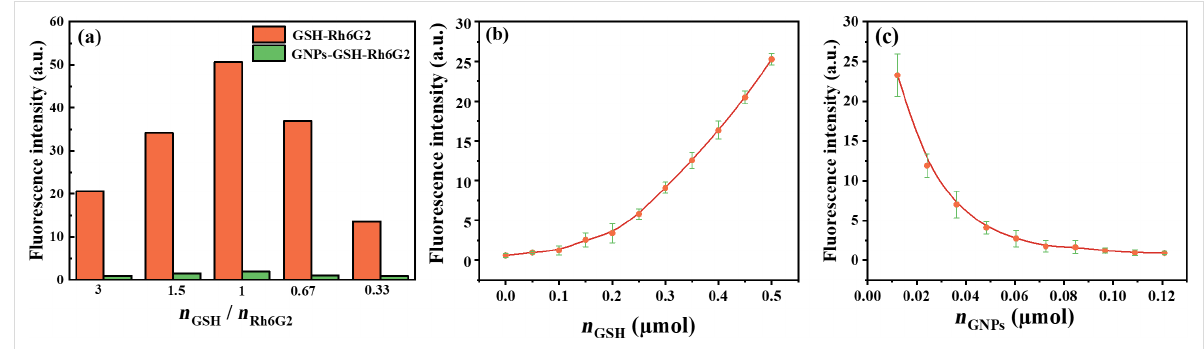
Figure 3: (a) Fluorescence intensity of GNPs-GSH-RH6G2 as function of the ratio between n GSH and n Rh6G2 ( n GNPs is 0.0726 µmol); (b) fluores- cence intensity of GNPs-GSH-Rh6G2 synthesized using different amounts of GSH ( n GNPs and n RH6G2 are 0.0726 µmol and 0.15 µmol, respectively); (c) fluorescence intensity of GNPs-GSH-Rh6G2 synthesized using different amounts of GNPs ( n GSH and n RH6G2 are 0.15